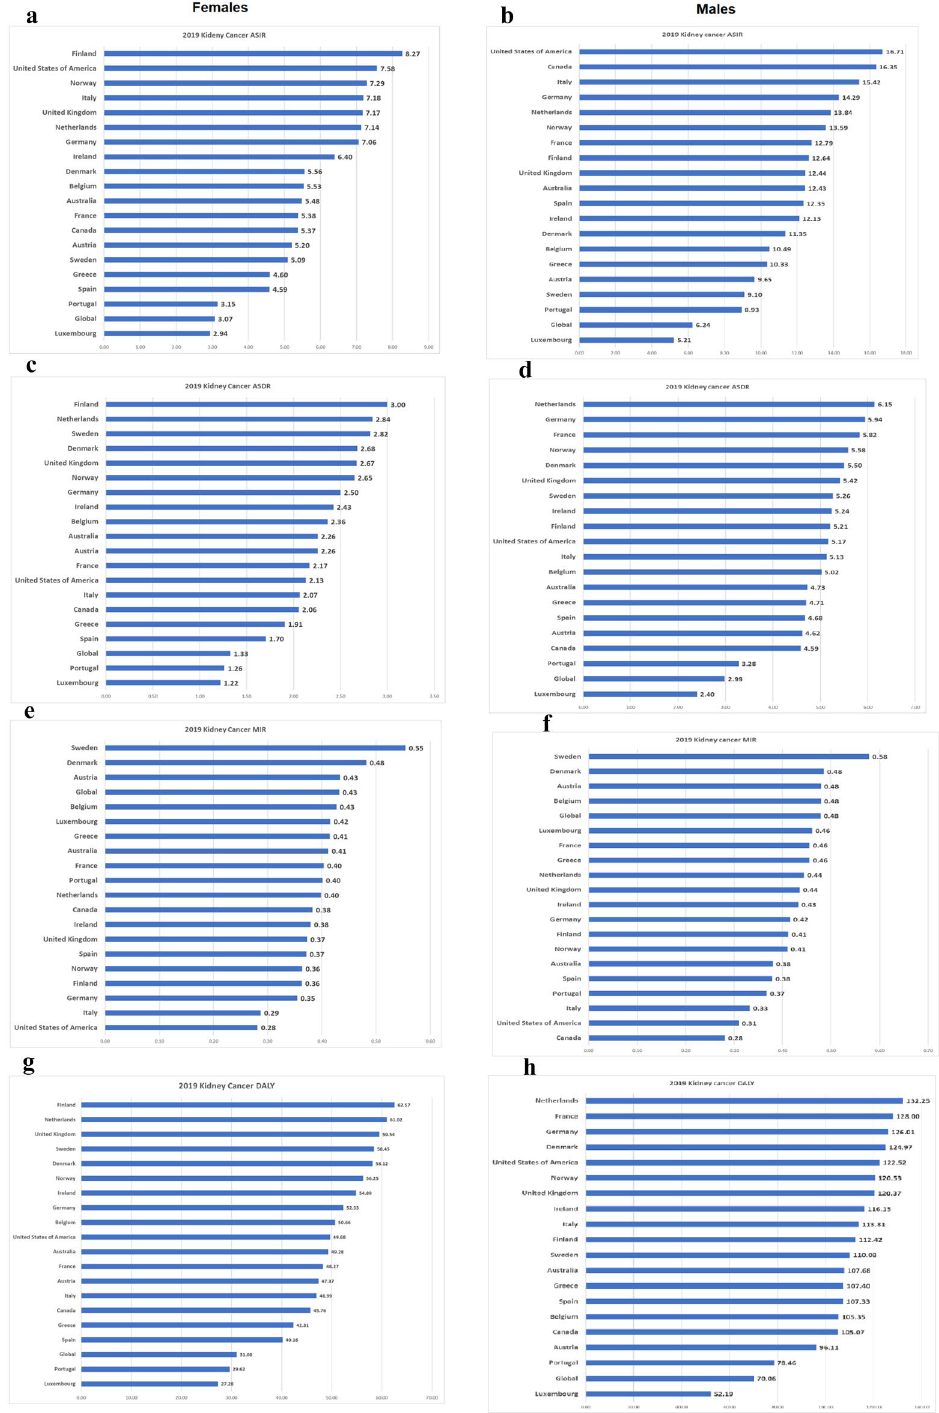
Figure 1. Age-standardized incidence rates (ASIR) for females ( a ) and males ( b ), age-standardized mortality rates for females (ASMR) ( c ) and males ( d ), mortality-to-incidence ratios (MIR) for females ( e ) and males ( f ), and disability-adjusted life years (DALYs) for females ( g ) and males ( h ) for kidney cancer (KC) for EU 15 + countries in 2019. All indices are per 100,000